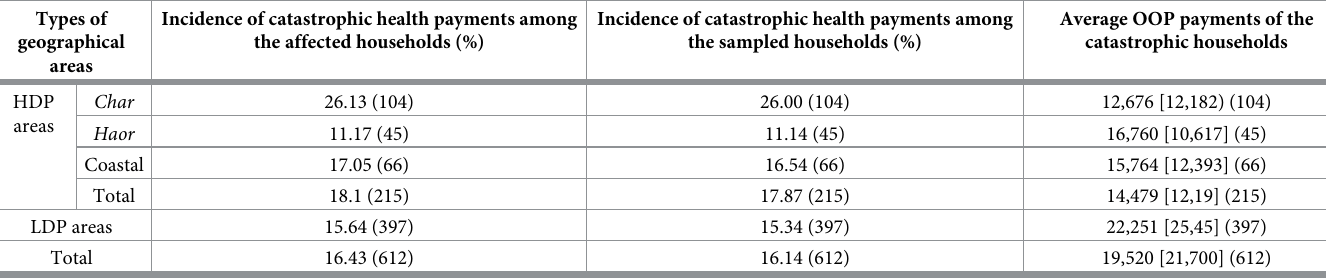
Table 4. Incidence of catastrophic health expenses (measured at 10% threshold level) by geographical areas.